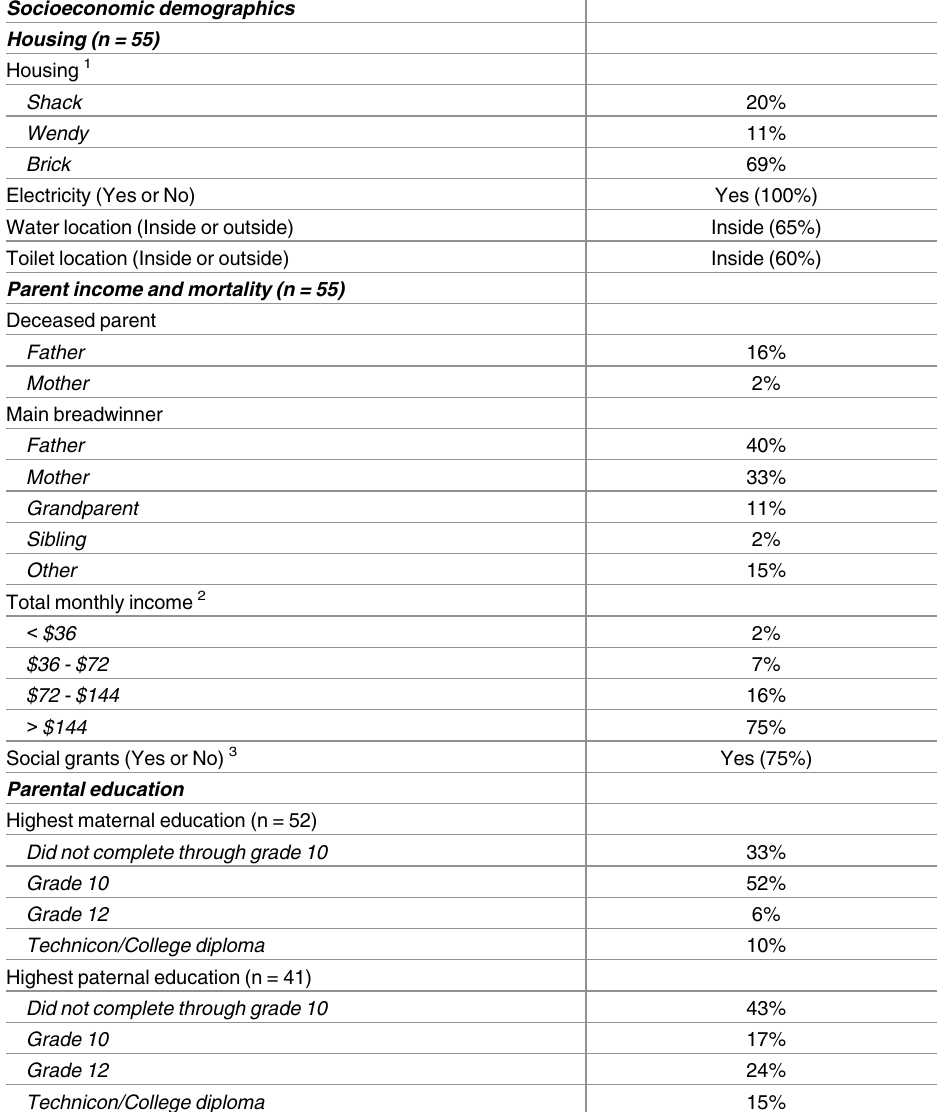
Table 1. Summary of sociodemographics for a subset of children